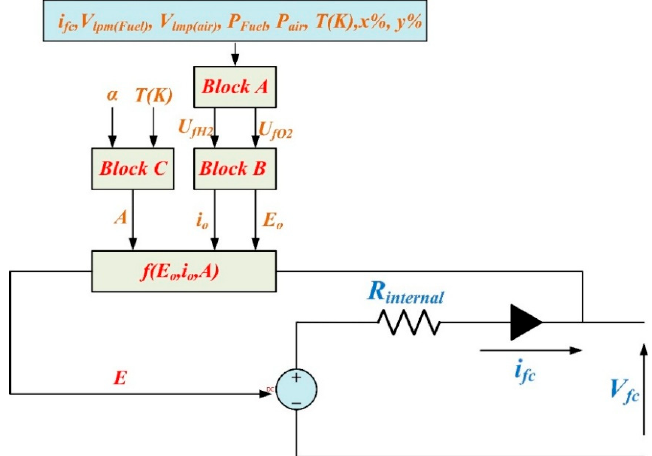
Figure 6. Fuel cell (FC) equivalent circuit.